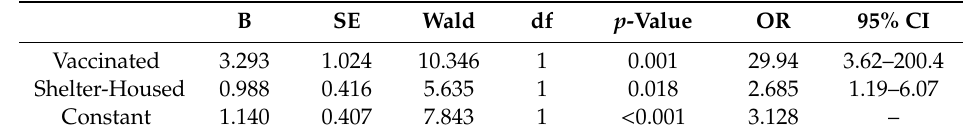
Table 2. Results of logistic regression analysis using model of best fit containing the variables: vaccinated, Sydney (outbreak) location, and shelter-housed.